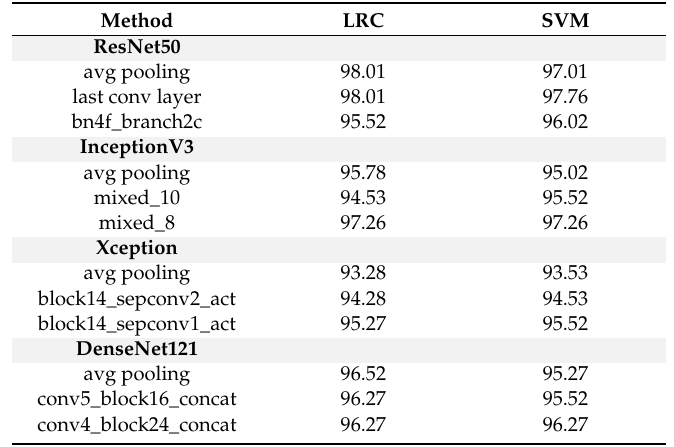
Table 2. The classification accuracy (OA (%)) of linear classification with LRC and SVM of features extracted from di ff erent layers with 60% of WHU-RS dataset as a training set.